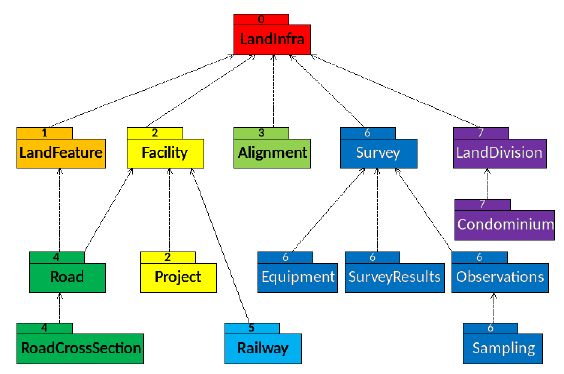
Figure 2. LandInfra Requirements Classes (OGC,